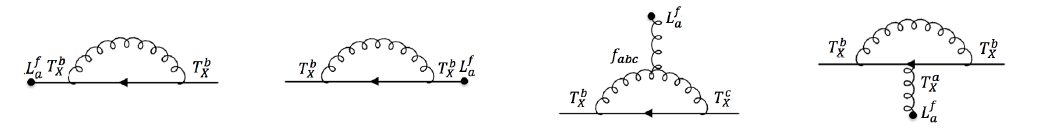
I 12 + C 13 I 13 . The chirality X is determined by the aX X aX X